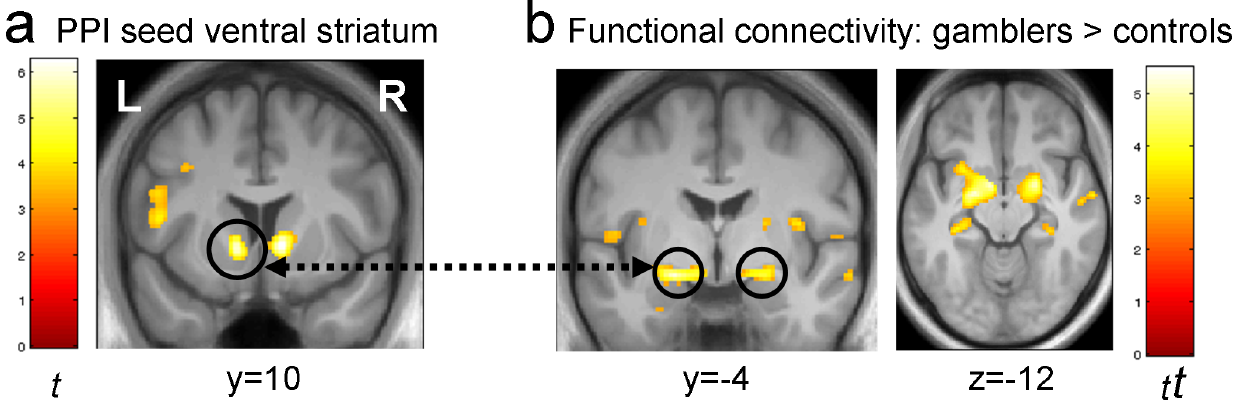
Figure 1. Results from the functional connectivity analysis in controls and pathological gamblers. a) A re-analysis of previously published fMRI data of decision-making in controls and gamblers revealed a main effect of subjective value across groups (controls and pathological gamblers) and conditions (delay and probability discounting). b) Functional connectivity of the left ventral striatum with bilateral amygdala was enhanced in the gamblers compared to the controls (left amygdala: p svc =.001, right amygdala: p svc =.005). Similar effects were seen when the seed was placed in the right ventral striatum (see Table 2). Left panels: display threshold p , 0.001 uncorrected, 10 voxels (a) and p , 0.005 uncorrected, 10 voxels (b). bilateral ventral striatum (Figure 1a, right: x,y,z coordinates 10, 10, 2 2, z-value = 5.41, p svc , .001, left: 2 10, 9, 2 9, z-value = 5.17,